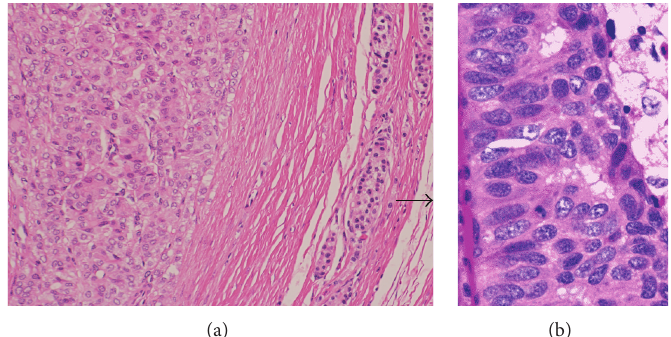
Figure3:(a)Infiltratingclustersofpapillarytumorcellsinpancreatictissueparenchyma(H&E × 100)and(b)follicularpatternwithabundant cytoplasm (H&E ×